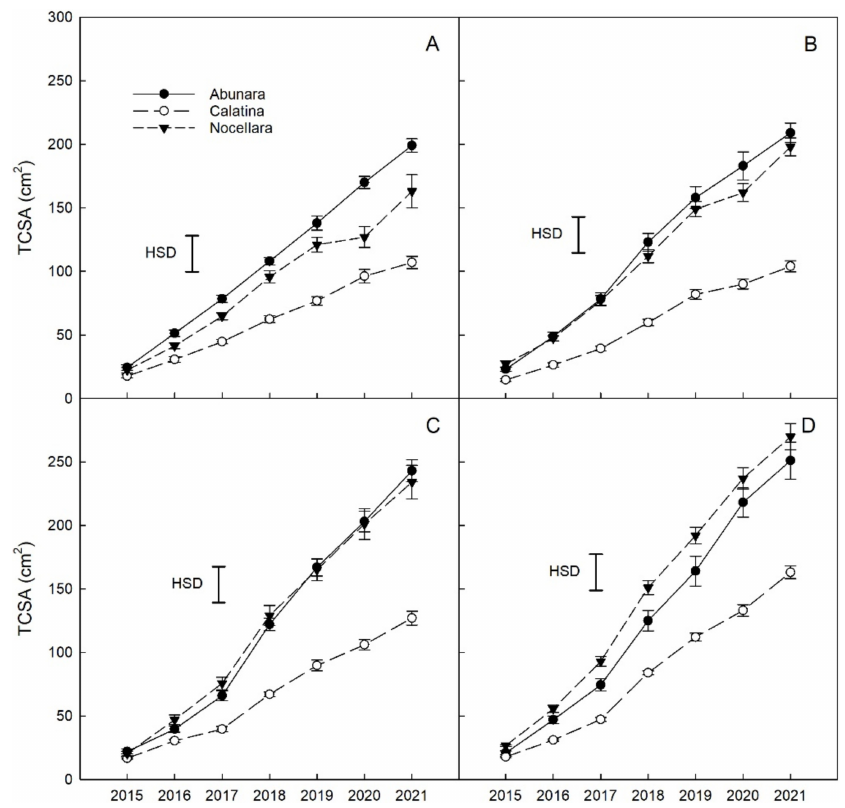
Figure 2. Trends of trunk cross-section area (TCSA) across the seven years of trial for ‘Abunara’, ‘Calatina’, and ‘Nocellara del Belice’ olive trees grown as central leaders at 2 × 5 m (CLx2, ( A )), free palmette at 3 × 5 m (FPx3, ( B )), globe vase at 4 × 5 m (GVx4, ( C )), and polyconic vase at 5 × 5 m (PVx5, ( D )). Error bars represent standard errors of the means. Mean separation by Tukey’s honestly significant difference (HSD, p <